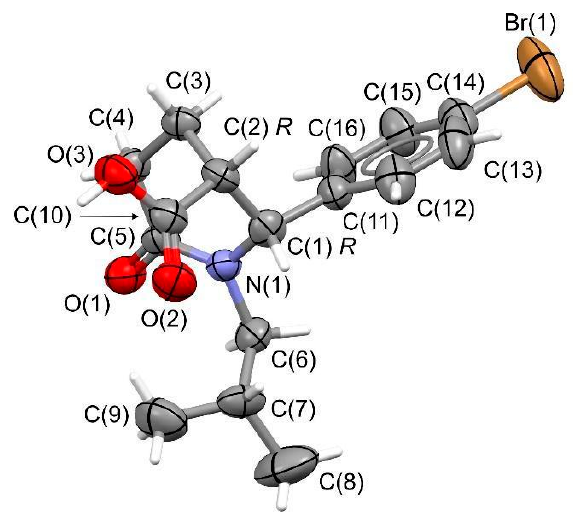
Figure 6. Molecular structure (drawn as plot showing thermal ellipsoids at the 50% probability level)